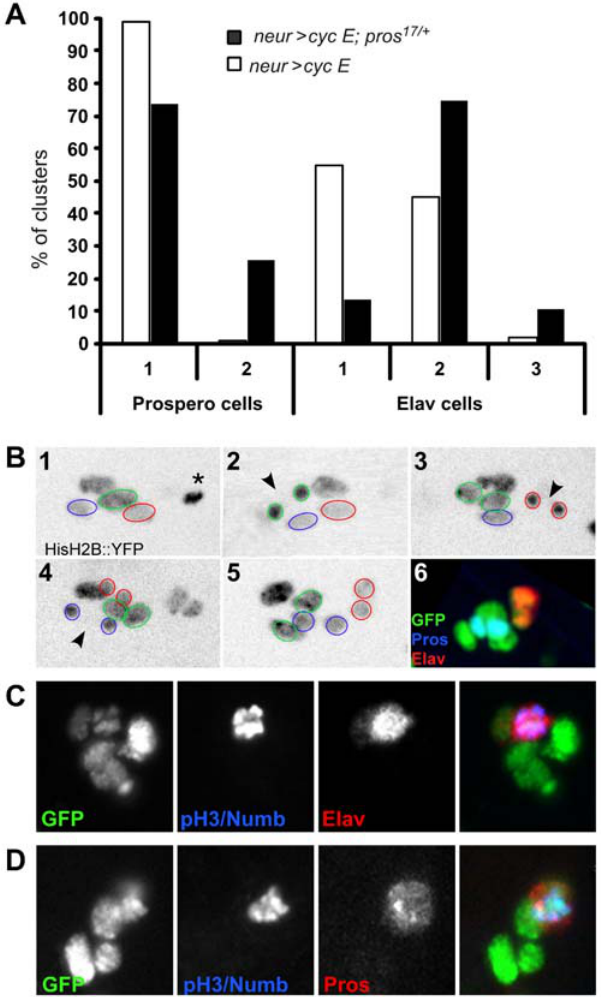
Figure 5. Pros prevents extra mitoses in the pIIIb sublineage. (A) Histogram showing the percentage of clusters containing one or two sheath cells and clusters with one, two or three neurons after CycE overexpression alone ( neur . CycE ) (white bars) and in a pros17/ + background (black bars), at 28 h APF. (B) Combined time lapse imaging in living pupae and immunostaining of pros17/ + , neur . CycE , H2B::YFP . Representative frames from the time-lapse recording are shown for one cluster. Cells encircled in green correspond to the future shaft cell and its progeny. Cells in red correspond to the neuron and its progeny and blue lines delimit the sheath cell and its progeny. The non-circled nucleus corresponds to the socket cell. (1) Cluster at 23 h APF showing the normal number of cells. The glial cell is undergoing apoptosis (asterisk). (2–4) Extra mitoses (future shaft in 2, neuron in 3 and sheath in 4) are indicated with an arrowhead. (5) Last frame of the movie. (6) Immunostaining of this cluster after the time-lapse recording. Neurons and sheath cells are identified by ELAV (red) and Pros (blue) immunoreactivity. Bristle lineage cells are revealed using an anti-GFP antibody (green). (C,D) No Numb protein was detected during pIIIb daughter cells division. The ELAV (C, in red) and Pros (D, in red) positive cells are mitotic cells as revealed by PH3 immunoreactivity (blue). neur . CycE , H2B::YFP , pros17/ + pupae at 24–25 h APF.